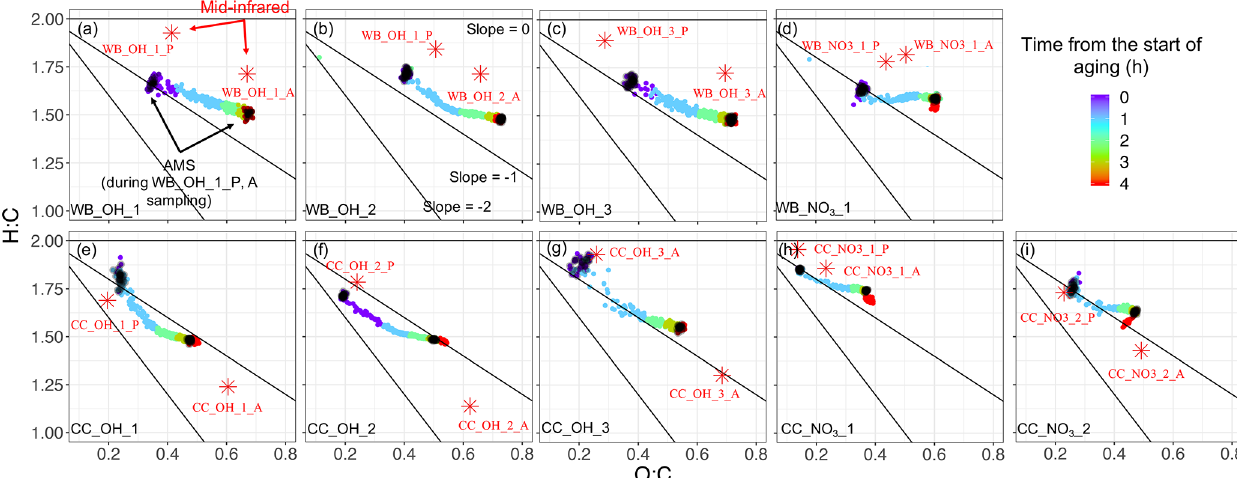
Figure 4. Comparison of AMS van Krevelen (H : C vs. O : C) aging trajectories (color circles) for wood burning (WB) and coal combustion (CC) experiments with MIR estimates for aerosols collected on PTFE filters before and after aging (red stars). Black circles in AMS trajec- tories correspond to the filter sampling periods for the primary and aged aerosols. The filter names are the same as Yazdani et al. (2021b). P: primary, A: aged. There are one to three similar experiments in each category (WB_OH, WB_NO 3 , CC_OH, and CC_NO 3 ). Table 1. Summary of important fragment ions for each functional group based on the analysis method. Important fragments are shown in bold. FGs Covariance Correlation VIP scores Multivariate regression CO + , CHO + , C 2 H 3 O + 2 Alkane (aCH) C x H + 2 x ± 1 large fragments: C 8 H + 17